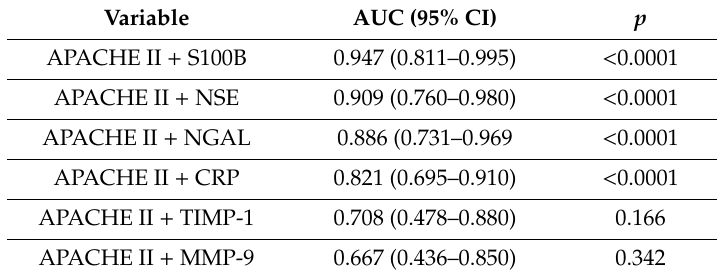
Table 7. Mortality prediction using a combination of APACHE II and the studied biomarkers 1